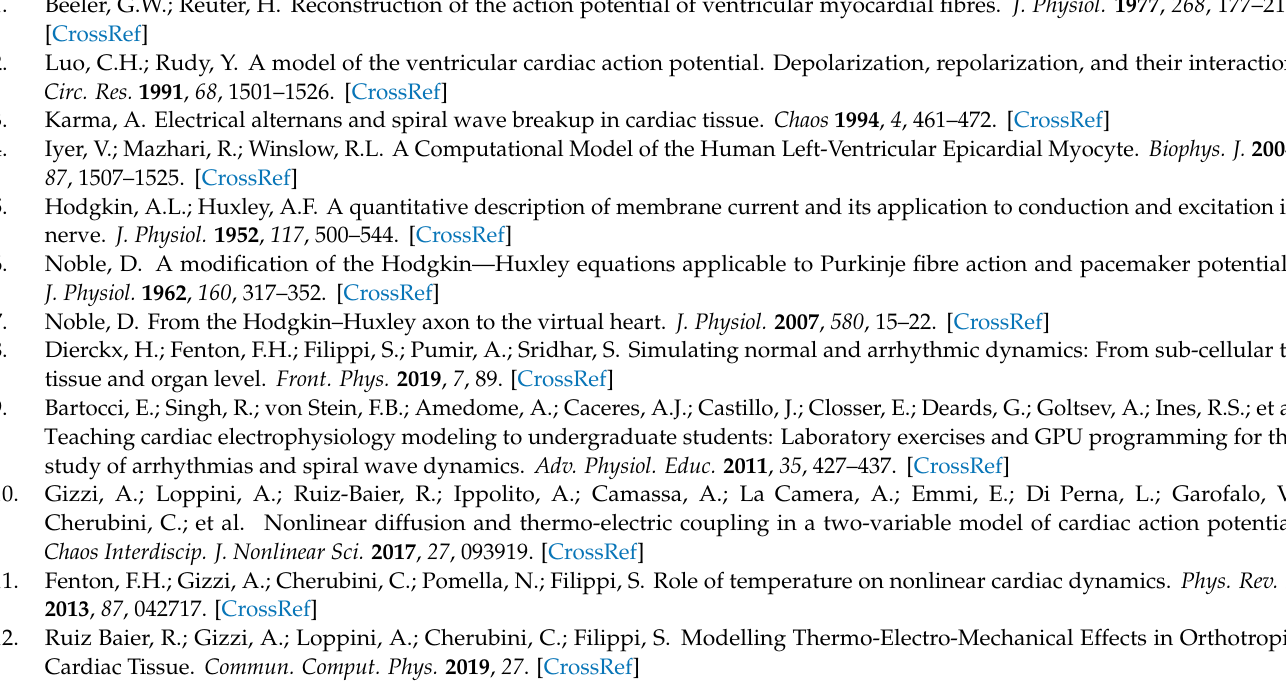
Figure A3. 5 cells grouped Matlab Simulink.